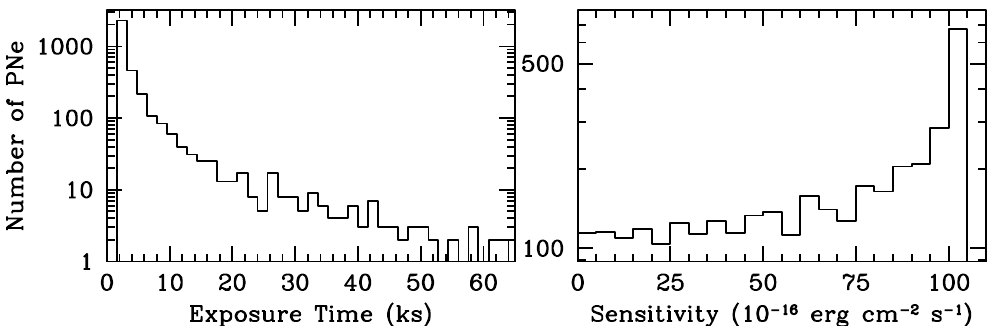
Figure 3. Distribution of exposure time (left) and sensitivity (rigth) for PNe expected in the final eRASS map of the whole sky. Most PNe will be located in areas of the eRASS with total exposure times shorter than 20 ks, but a significant number of them, (cid:39) 200, will have longer exposure times. Accordingly, a significant number of PNe, those with long exposure times in the final eRASS, will have observations with sensitivities adequate to detect X-ray fluxes smaller than (cid:39) 2 × 10 − 15 erg cm − 2 s − 1